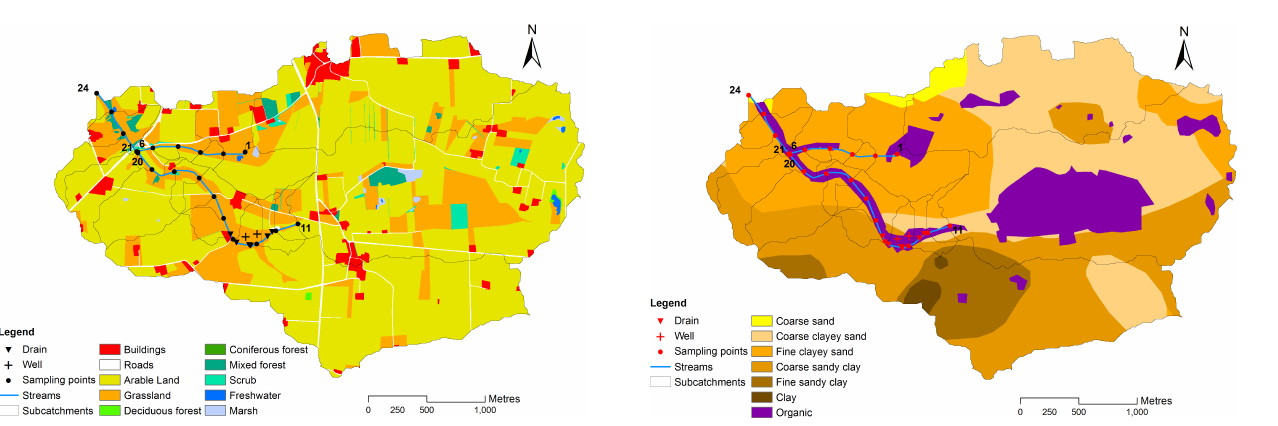
Fig. 2. Soil type distribution over the Bjerringbro study area with stream network, delineated subcatchments and selected sampling site numbers along the stream (based on the soil type map from Dalgaard et al.,